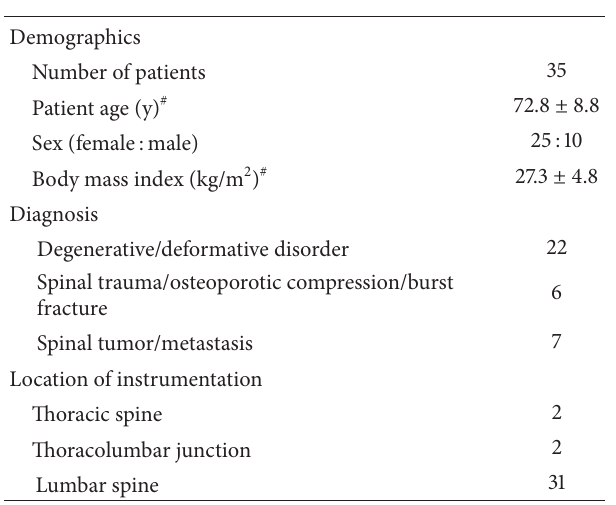
Table 1: Patient characteristics. The table shows demograph- ics, underlying cause for performing minimally invasive cement- augmented screw-rod spondylodesis and spine region of the instru- mentation.